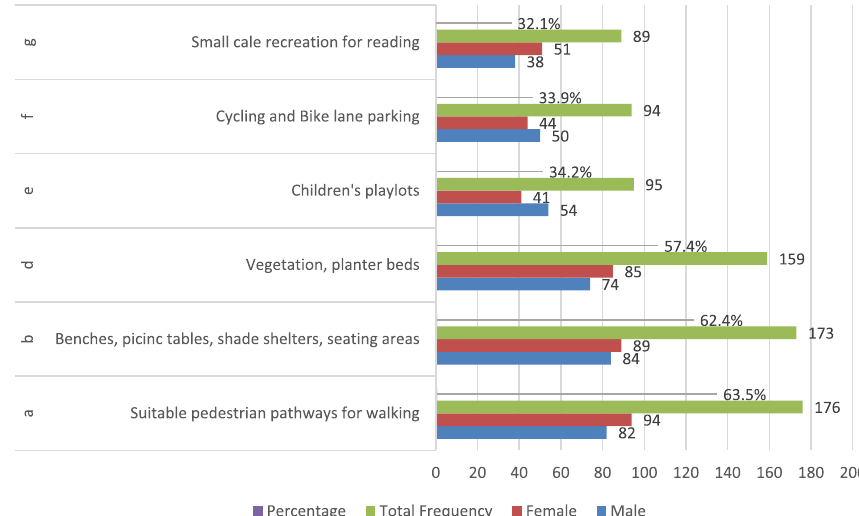
Fig. 7 Priorities of the principles of tactical urbanism in future